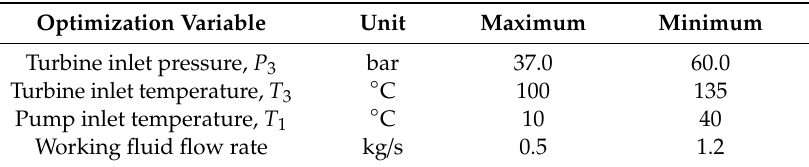
Table 2. Maximum and minimum values of optimization